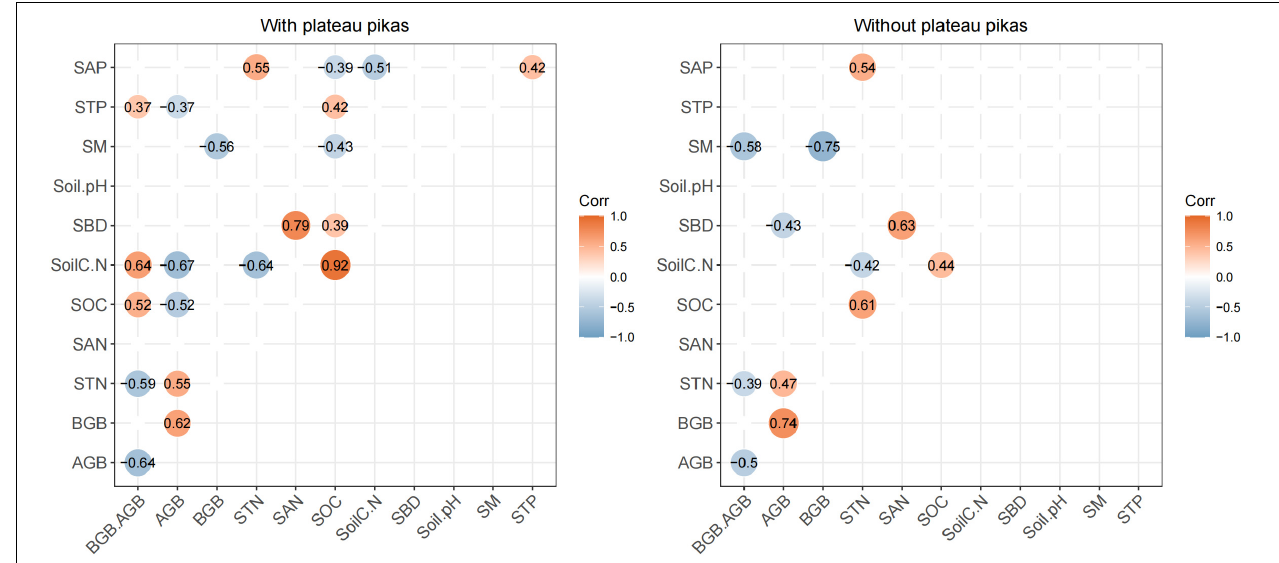
FIGURE 4 | The relationships of BGB/AGB with environmental factors in areas with and without plateau pikas. Orange indicates a positive correlation at p < 0.01, and blue indicates a negative correlation at p < 0.01. STN, soil total nitrogen; SAN, soil available nitrogen; SOC, soil organic carbon; soil C:N, soil carbon/soil nitrogen; STP, soil total phosphorus; SAP, soil available phosphorus; SM, soil moisture; SBD, soil bulk